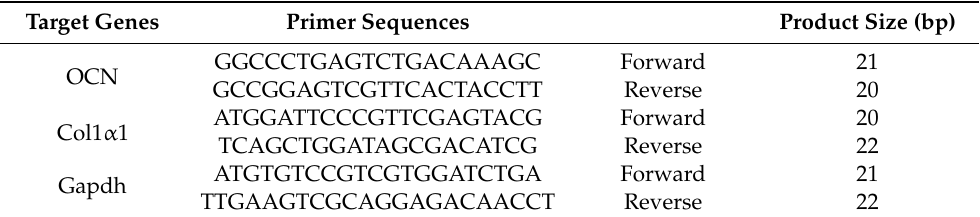
Table 1. Primer sequences for target